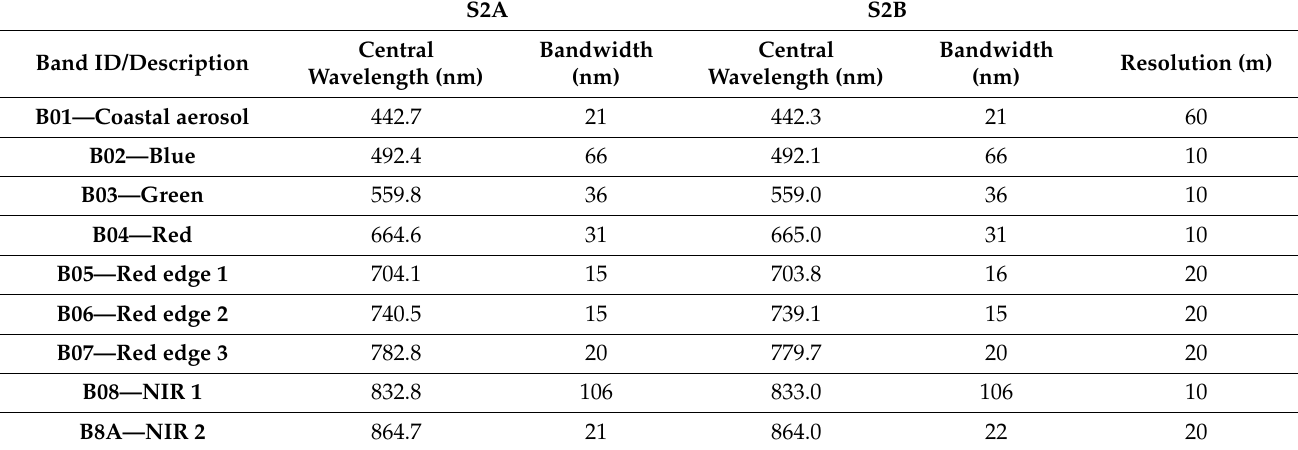
Table 3. The list of Sentinel-2 S2MSIL2A product used